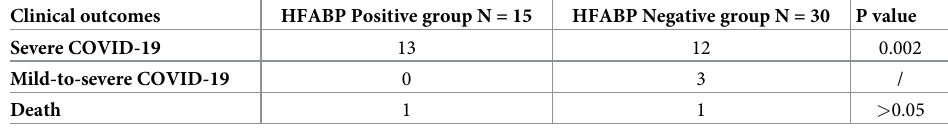
Table 2. Clinical outcomes of the matched study population of COVID-19 with HFABP levels. Clinical outcomes Severe COVID-19 0.002 Mild-to-severe COVID-19 0 3 / Death 1 1 > 0.05 Heart fatty acid-binding protein = HFABP.